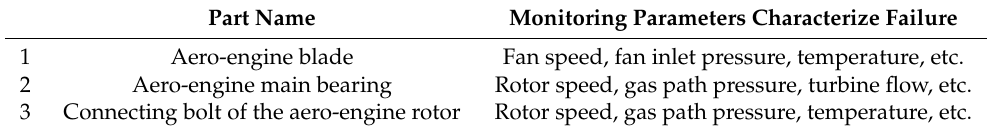
Table 1. Key components of the aero-engine and the monitoring parameters characterized the